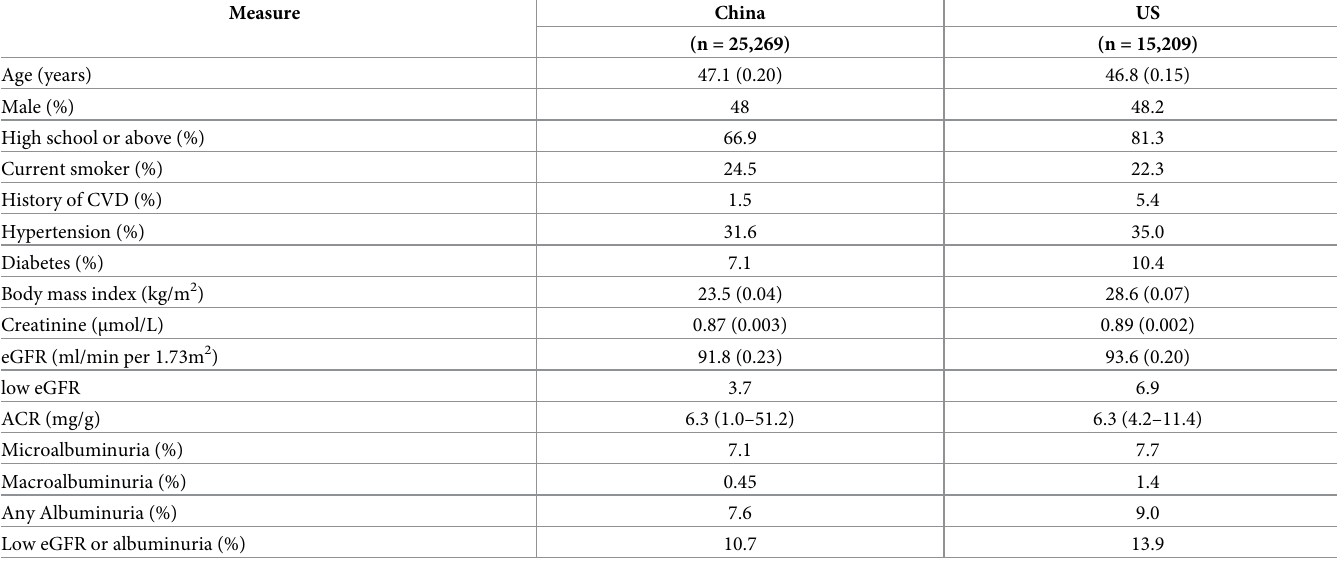
Table 1. Comparison of Demographic Characteristics between China and the US (cid:3) .